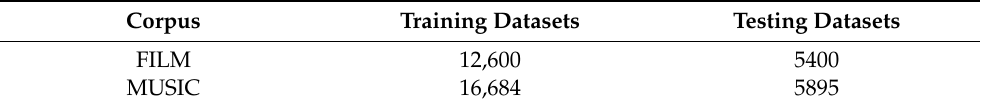
Table 1. Information of two major